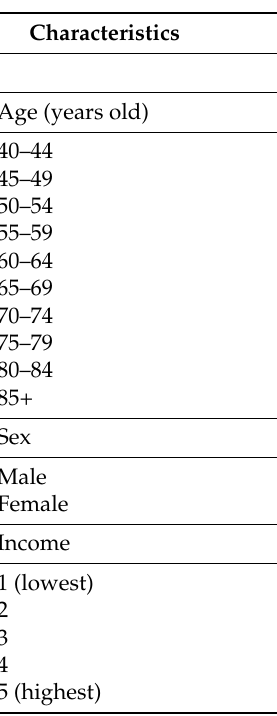
Table 1. General characteristics of